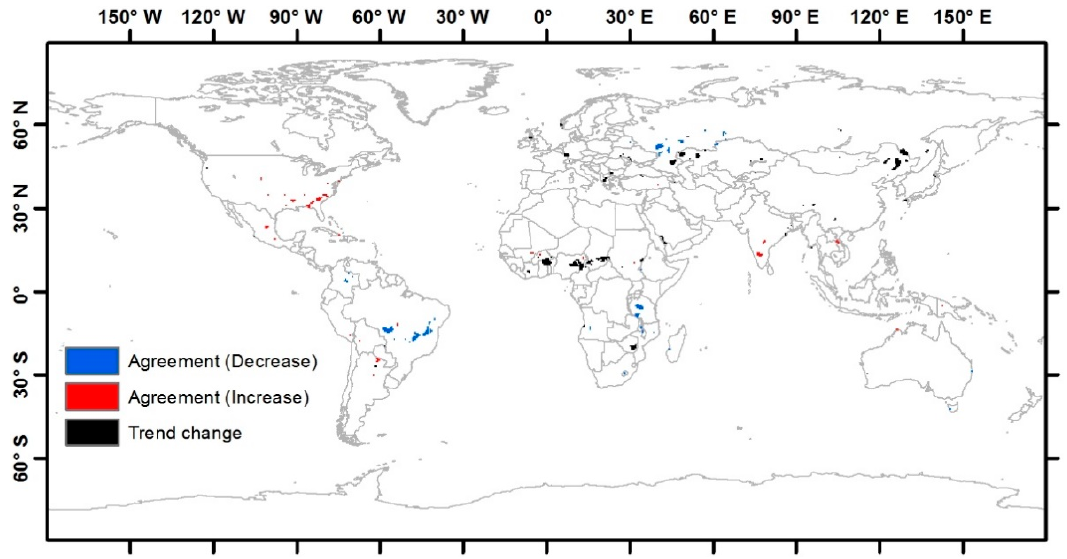
Figure 10. Spatial comparison (Agreement-Trend change) of significant trends between the 1982–2000 period and the 2001–2018 period of the FireCCILT11 BA product.